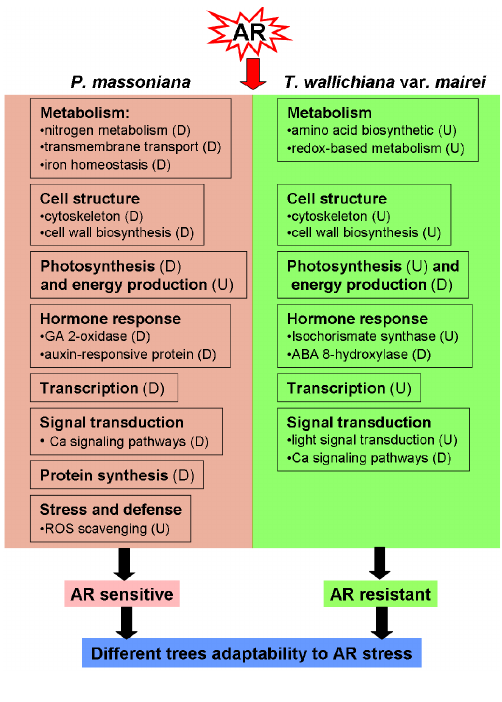
5. A schematic representation of different AR-tolerance mechanisms in P. massoniana and T. wallichinana var. mairei by regulating diverse biological processes. “U” or “D” indicate increase or decrease,